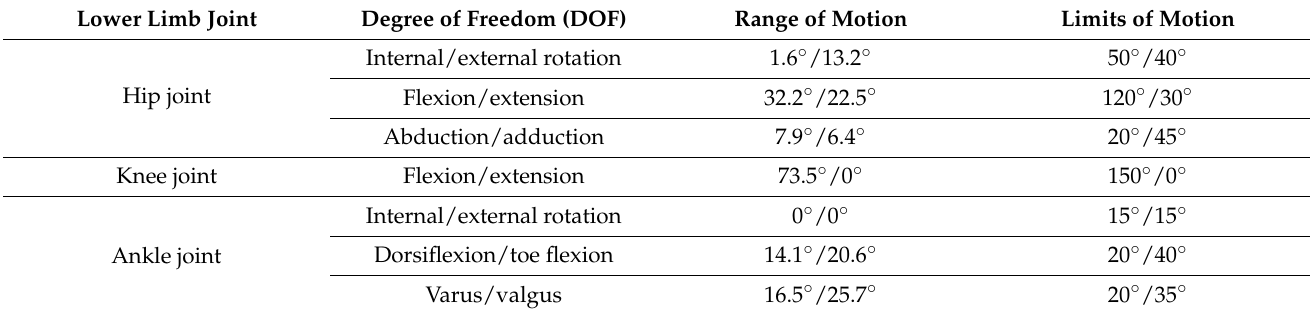
Table 1. Motion range of lower limb joints.